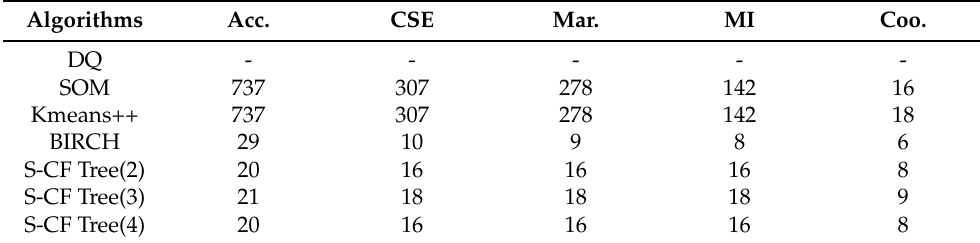
Table 5. Complexity tests (#hops) with feature selection (FP-Growth).